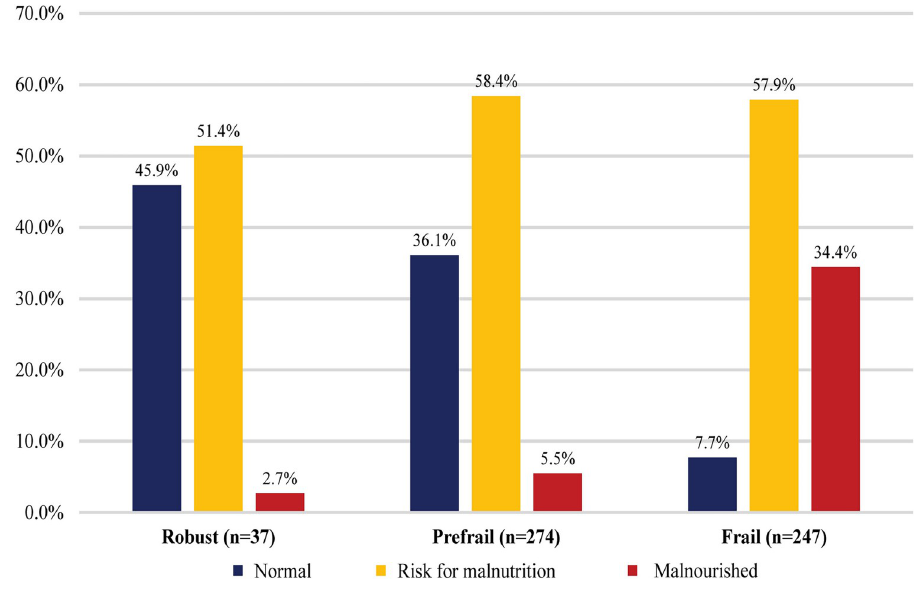
Fig 1. Prevalence of malnutrition according to frailty group.